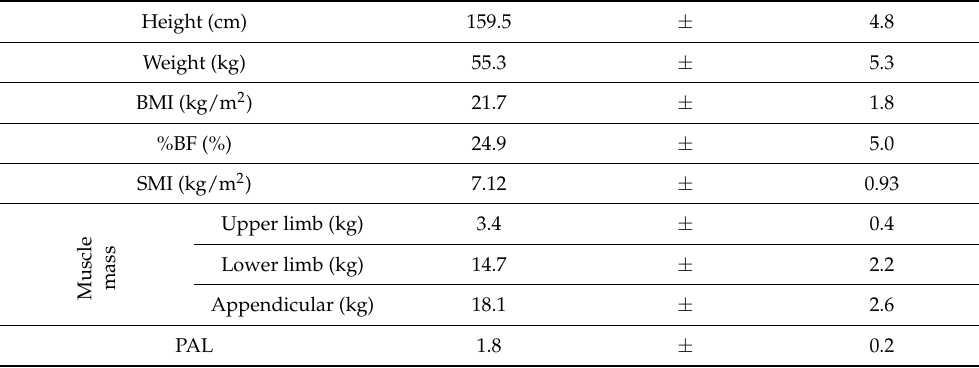
Table 1. Means and standard deviations of each variable of the entire participants. Height (cm)